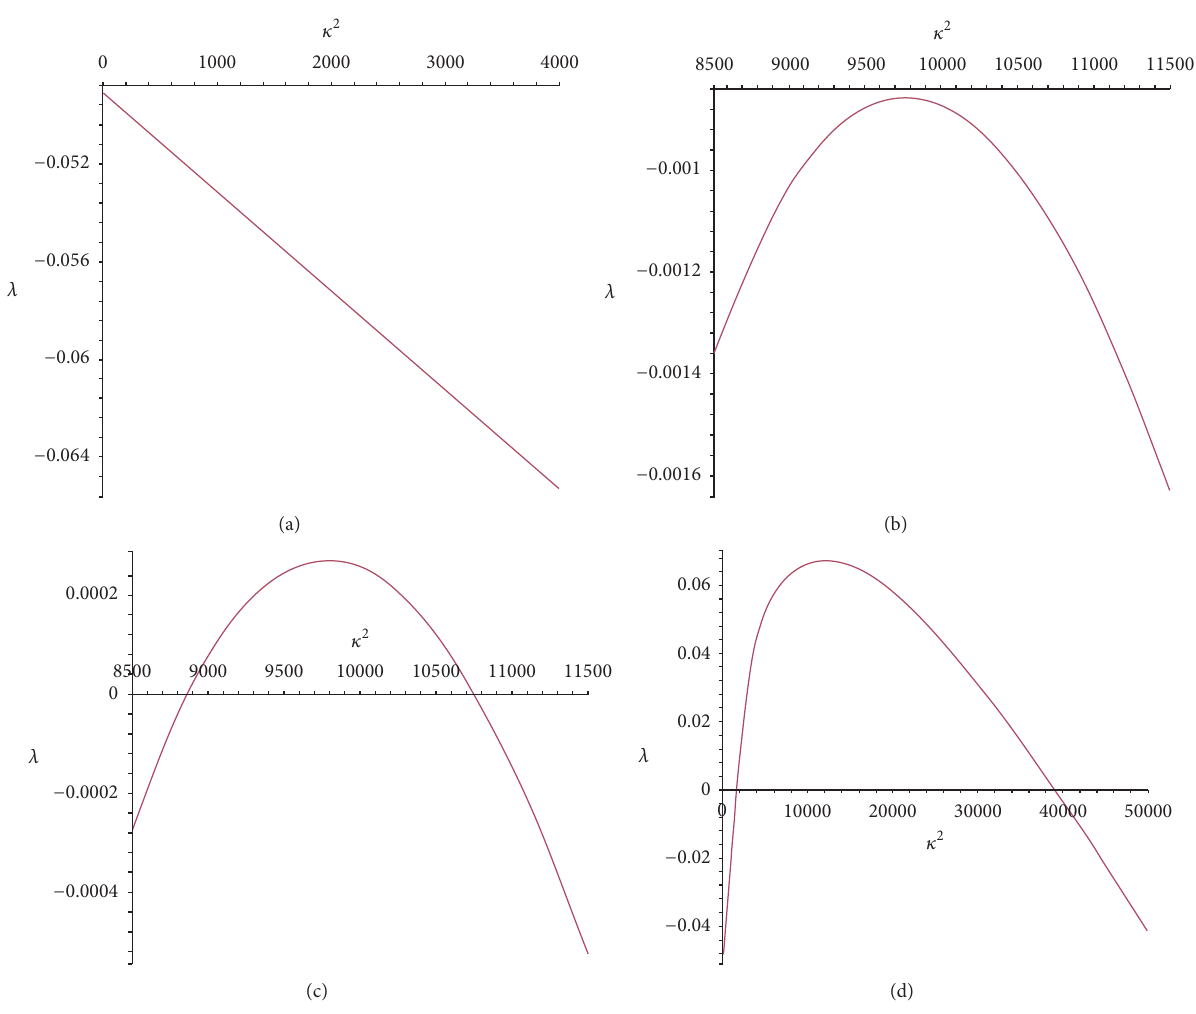
Figure 1: Dispersion curves of 𝜅 2 ( 𝑥 -axis) against the largest R (𝜆) ( 𝑦 -axis) for 𝜒 1 = 𝜒 2 = 0 (a), 𝜒 1 = 𝜒 2 = 0.000535 (b), 𝜒 1 = 𝜒 2 = 0.000545 (c), and 𝜒 1 = 𝜒 2 = 0.0015 (d) (see [1] for